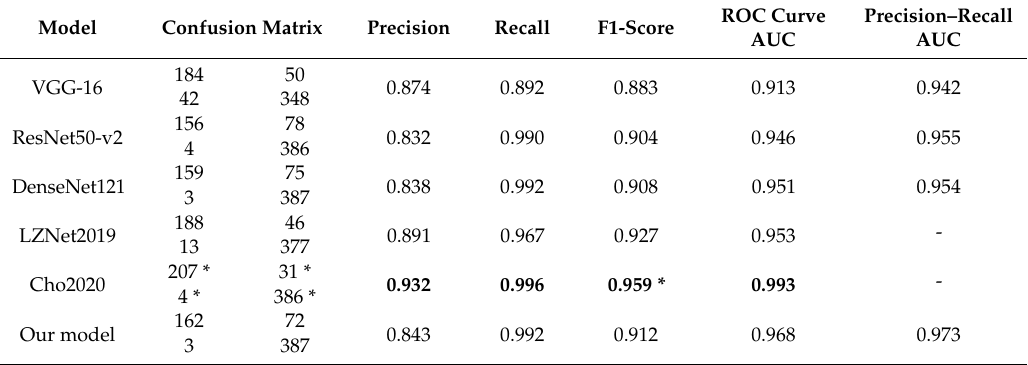
Table 4. Confusion Matrices (CMs) and performance measures of different models for pneumonia classification on the test set. Green fields were found by reverse engineering of paper metrics.